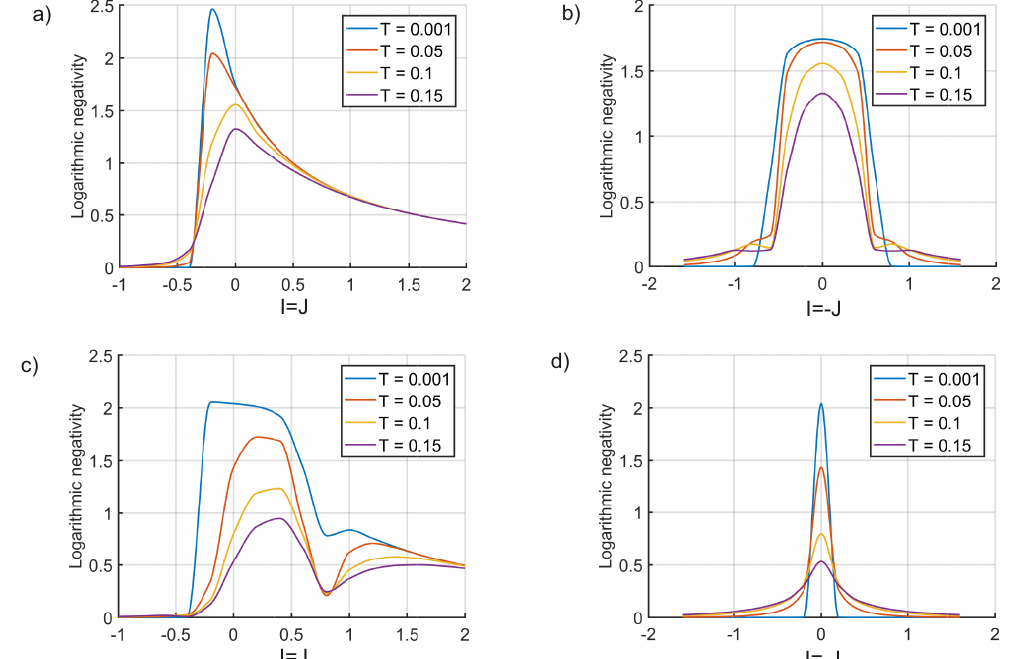
Figure 3: (a) Temperature evolution of the entanglement for the main diagonal of the I − J plane ( I = − 1, J = − 1)-( I = + 1, J = + 1), and negative intersubsystem exchange K = − 1. Two vivid effects are clearly seen. The first one — different rates of the entanglement decay with temperature near the maximum and far from it (and even the resistance of entanglement to temperature for I = J ≳ 1). The second — the non-monotonic behavior of the entanglement with temperature to the left of the maximum. (b) The same for the antidiagonal of the I − J plane ( I = − 1, J = + 1)-( I = + 1, J = − 1). Difference of the entanglement decay rates is visible, though less, than in panel (a). The non-monotonicity of the temperature dependence is obvious on both sides of low-temperature entanglement ‘cliff’. (c) Temperature evolution of the entanglement for the main diagonal of the I − J plane ( I = − 1, J = − 1)-( I = + 1, J = + 1), and positive intersubsystem exchange K = + 1. The non-monotonicity of the entanglement with temperature is hardly distinguish- able, but can be detected in two different regions: to the left of the maximum and for I = J ∼ 0.8. The common asymptotics of the curves is seen for large I , J . (d) The same for the antidiagonal of the I − J plane ( I = − 1, J = + 1)-( I = + 1, J = − 1). One can see considerable temperature growth of the entanglement at both sides of the maximum, where at low temperature it is